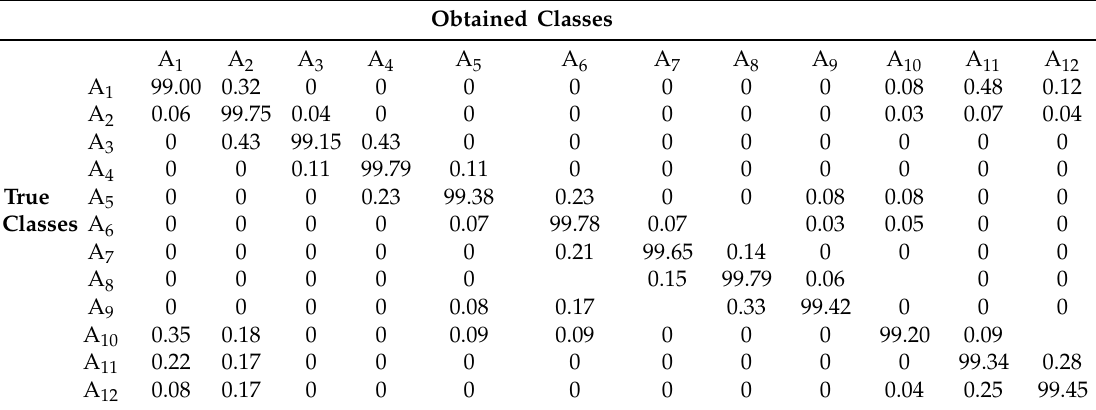
Table 9. Global confusion matrix obtained with k-NN using selected